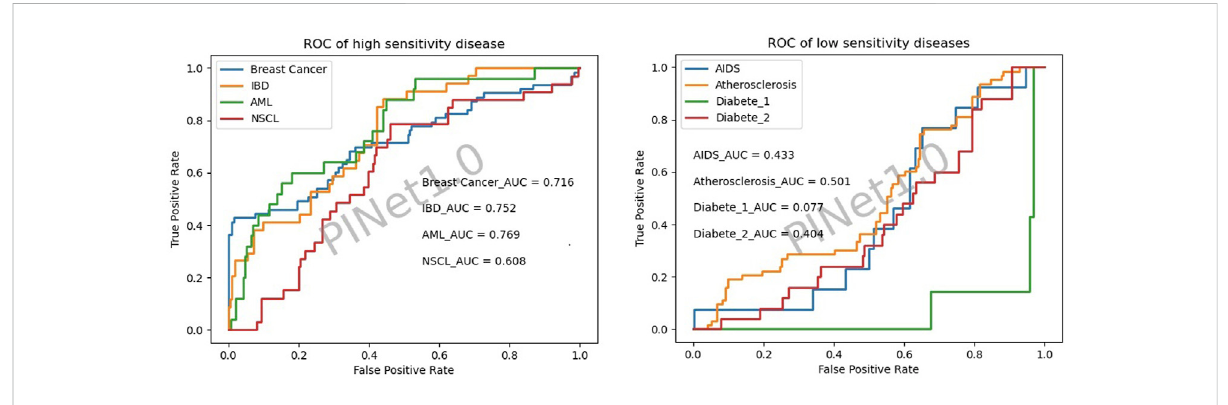
FIGURE 3 Disease sensitivity of PINet.